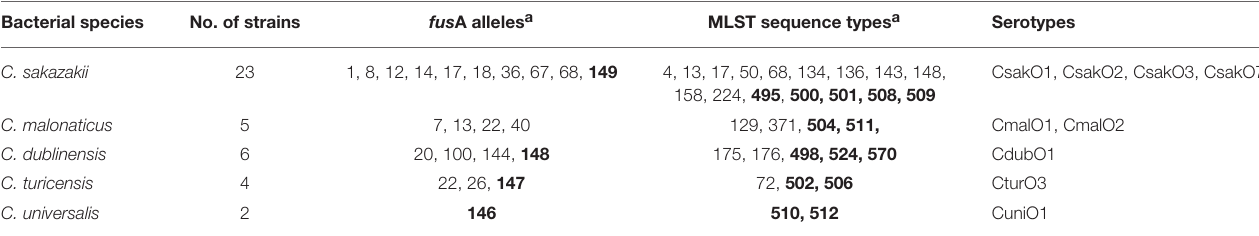
a New alleles and new STs are indicated in bold